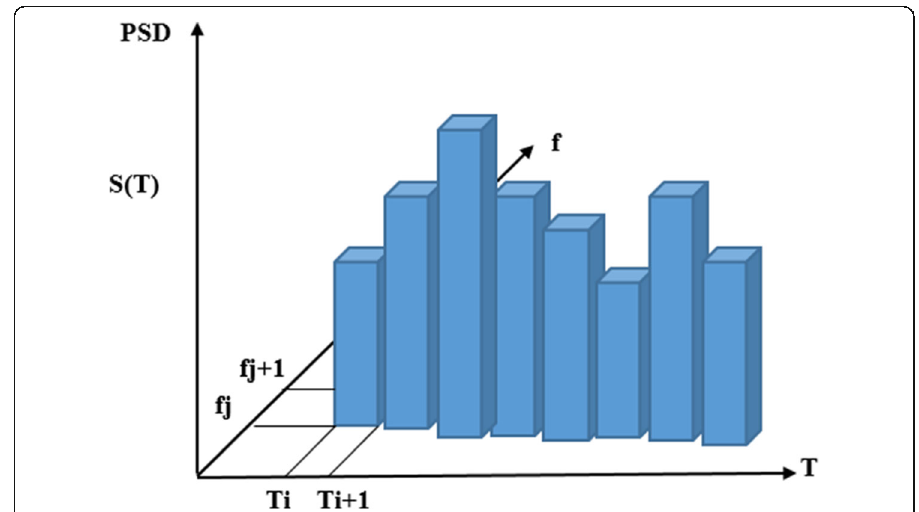
Fig. 20 Schematic for spectrum height with frequency and period